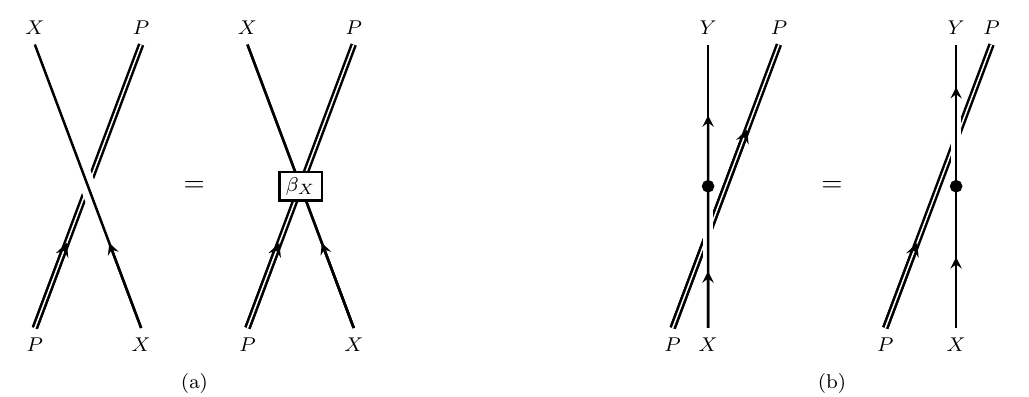
Figure 19 . Properties of boundary image of bulk lines. These properties imply that the bulk lines are elements of the Drinfeld center of the spherical fusion category formed by boundary lines.